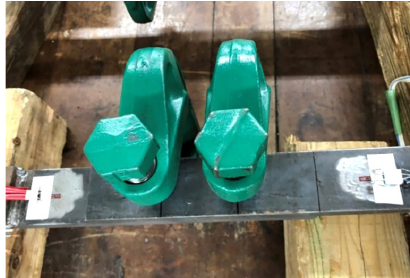
Figure 8. Specimen clipped by the two